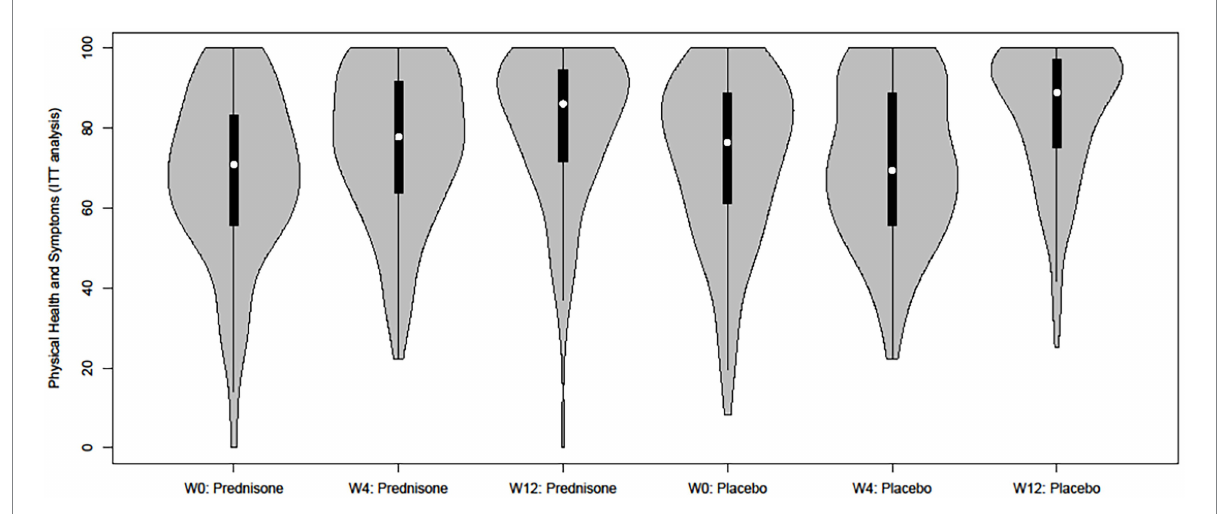
FIGURE 1 Grouped violin plot of the Physical Health and Symptoms score per intervention arm and time point (intent-to-treat).